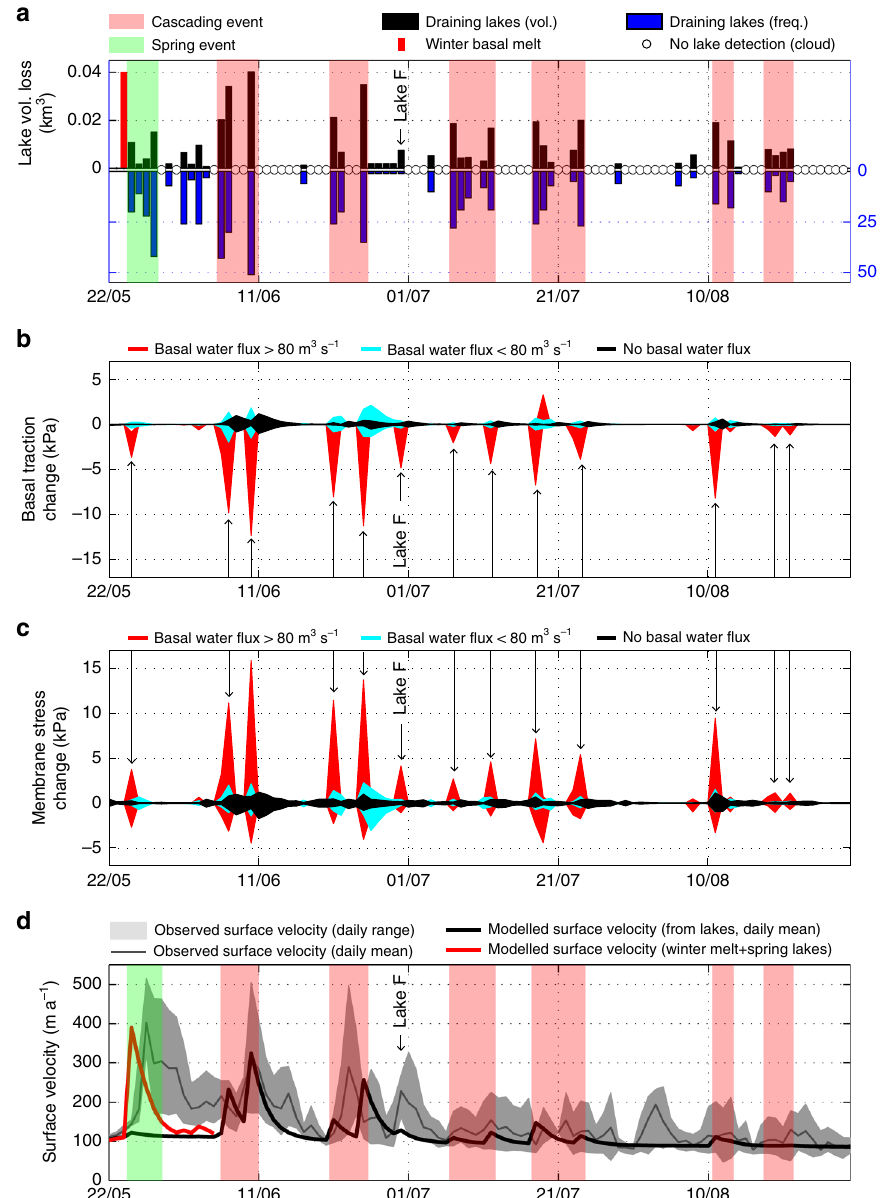
Fig. 2 Lake drainage and activation of the membrane stress. a Supraglacial lake drainage record used to force numerical model (Data from Fitzpatrick et al. 1 ). Black (blue) bars show volume (frequency) of draining lakes. Red bar shows modelled quantity of basal meltwater produced in winter and assumed to be released when the fi rst lakes drain. Green shaded area shows a spring speed-up event. Shaded red areas outline cascading events which occur when lakes drain in rapid succession, causing ice fl ow to transiently accelerate. b Change in basal traction averaged over regions of the bed where the basal water fl ux in grid cells of model is high (>80 m 3 s − 1 , red), moderate (<80 m 3 s − 1 , teal) and nil (black). The change is averaged across sections of the bed and is relative to day before. Arrows mark major perturbations at high- fl ux drainage paths and Lake F refers to the drainage event reported by Doyle et al. (ref. 6 ). c Same as b but showing change in the membrane stress within the ice sheet. Arrows mark the transient activation of the membrane stress along high- fl ux drainage paths along the bed. Note how changes in membrane stress correspond to changes in basal traction. d Mean daily surface velocity recorded at site SHR (67.099°N, 49.936°W) with GPS (grey solid line with shading showing range of daily variation) and modelled daily surface velocity at the same location (black solid line) when ice sheet model is forced by lake volumes shown in a . Model explains 83% of summer observations spanning June, July and August. Red solid line shows spring speed-up event simulated in a separate experiment in which 0.04 km 3 of basally produced meltwater (red bar in a ) is stored subglacially in winter, when the terminus freezes, and released when the fi rst lakes begin to drain in May (see